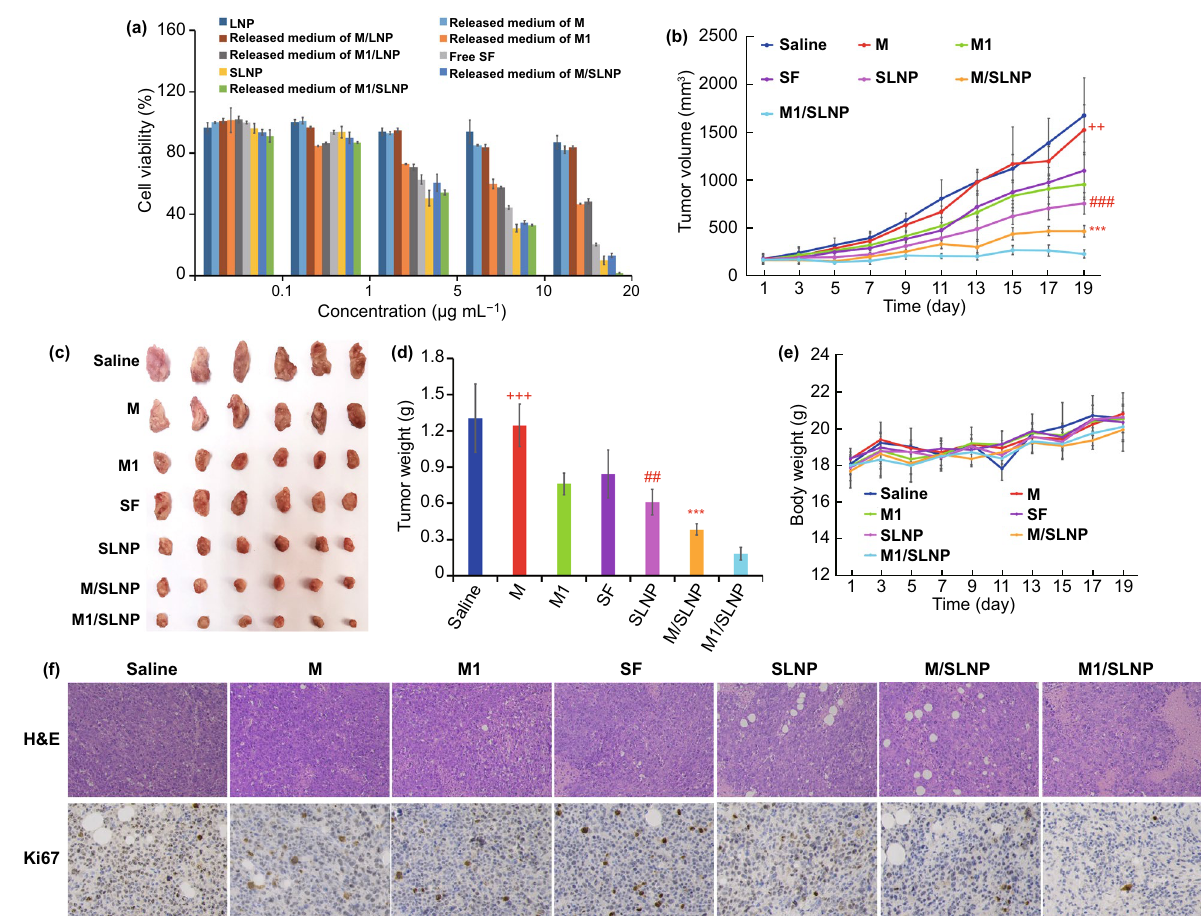
Fig. 4 M1/SLNP enhanced antitumor efficacy in vitro and in vivo. a Cell viability of M1/SLNP in Hepa1-6 cells in vitro . b In vivo tumor volume changes. c Photographs of tumors. d Tumor weights. e Body weight changes from Hepa1-6-bearing mice treated with NS, M, M1, free SF, SLNP, M/SLNP, and M1/SLNP via the tail vein. f H&E and Ki67 results of tumor tissues. Magnification: H&E 200× , Ki67 200× . +++ p < 0.001, ++ p < 0.01, compared with M1; ## p < 0.01, ### p < 0.001, compared with M/SLNP; *** p < 0.001, compared with M1/ SLNP, n =